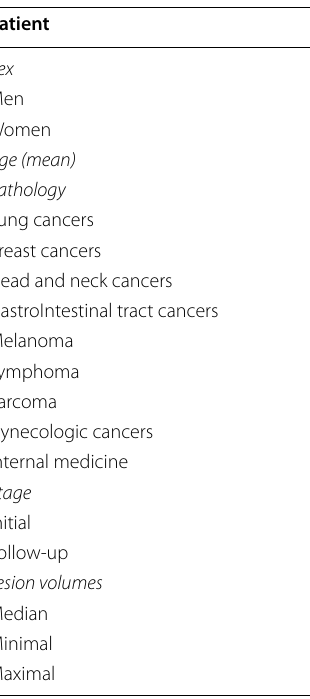
Table 5 Patient and lesion characteristics